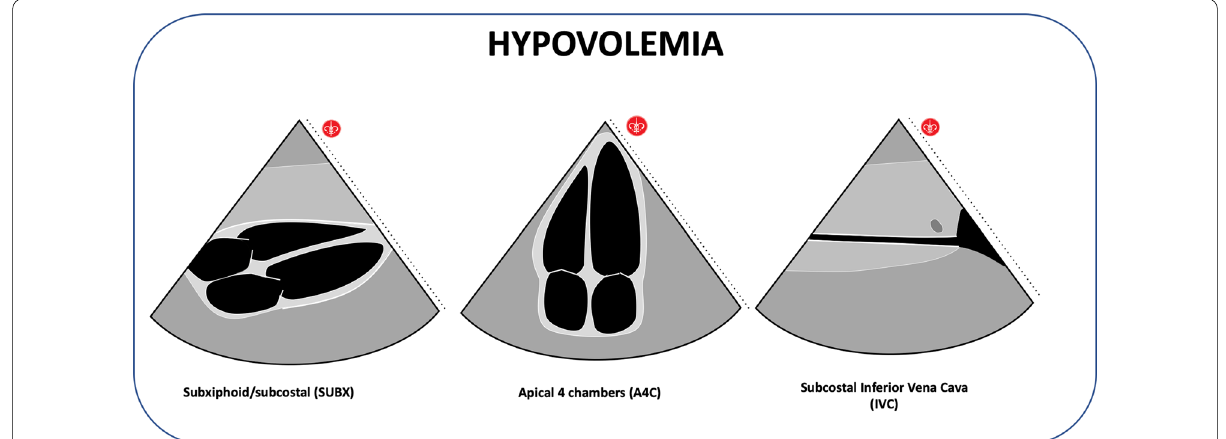
Fig. 8 Hypovolemia